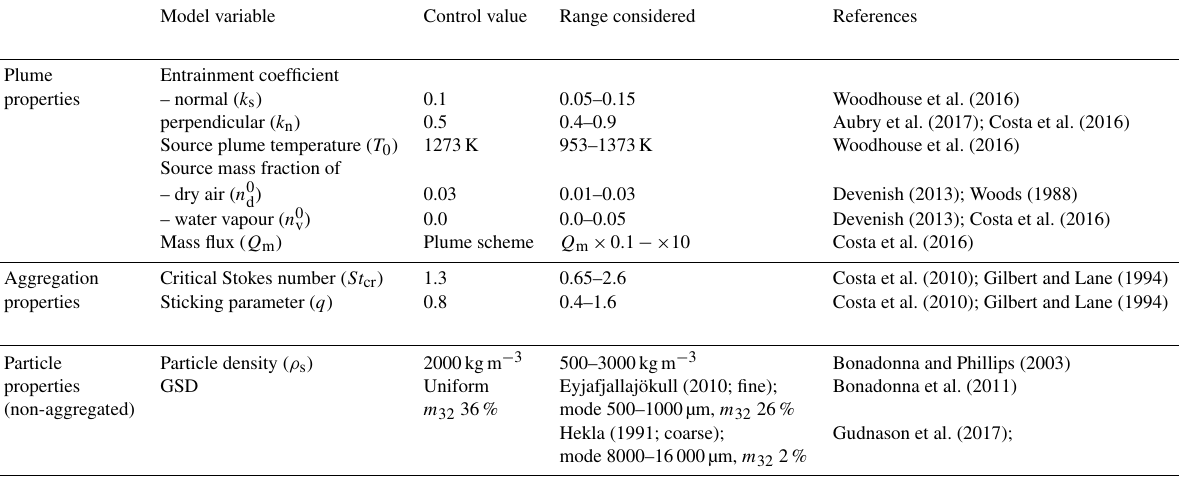
Table 3. Model variables used in the aggregation scheme to represent the eruption conditions. The control values listed for each parameter are based on the defaults used in the existing literature. The range of parameter values considered in the sensitivity study are also given.